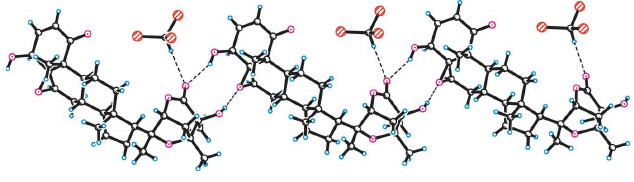
Figure 3 Hydrogen bonding in the crystal structure of I (the molecules are cross- linked along the c